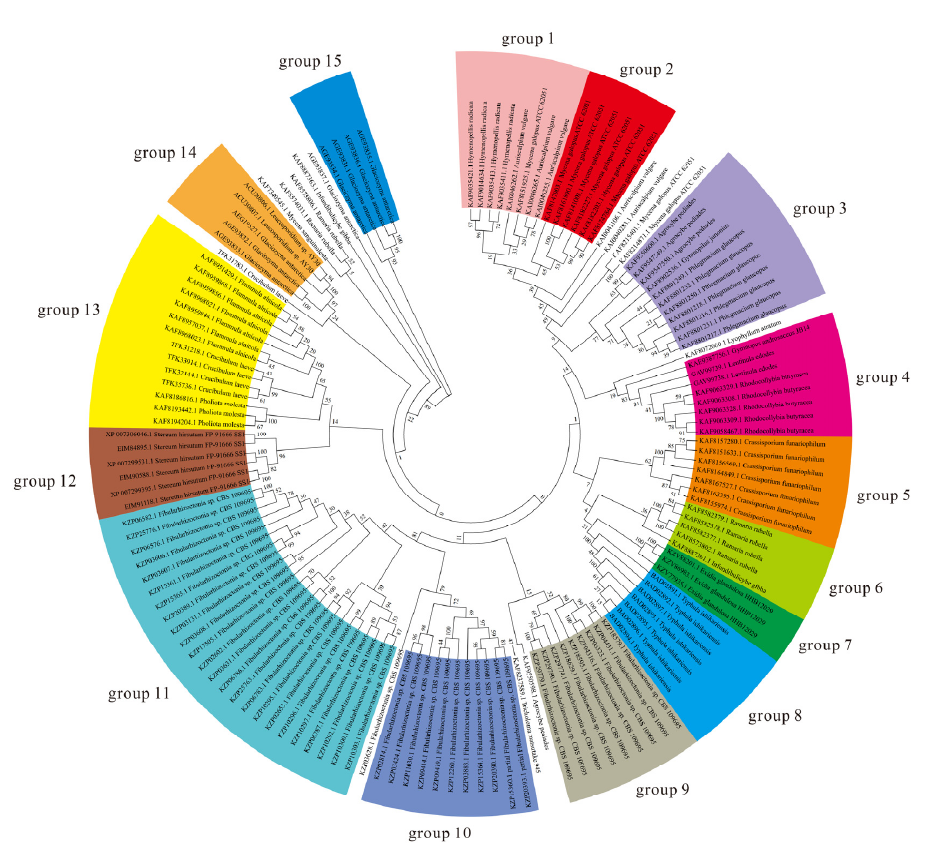
Figure 2. Phylogenomic trees of AFPs.